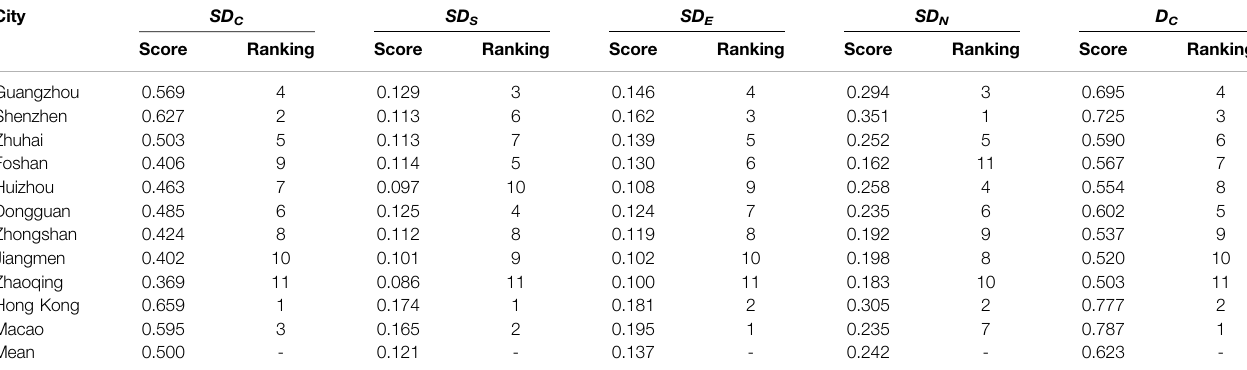
TABLE 4 | Results of the sustainable development level of the compound ecosystem in the GBA. City